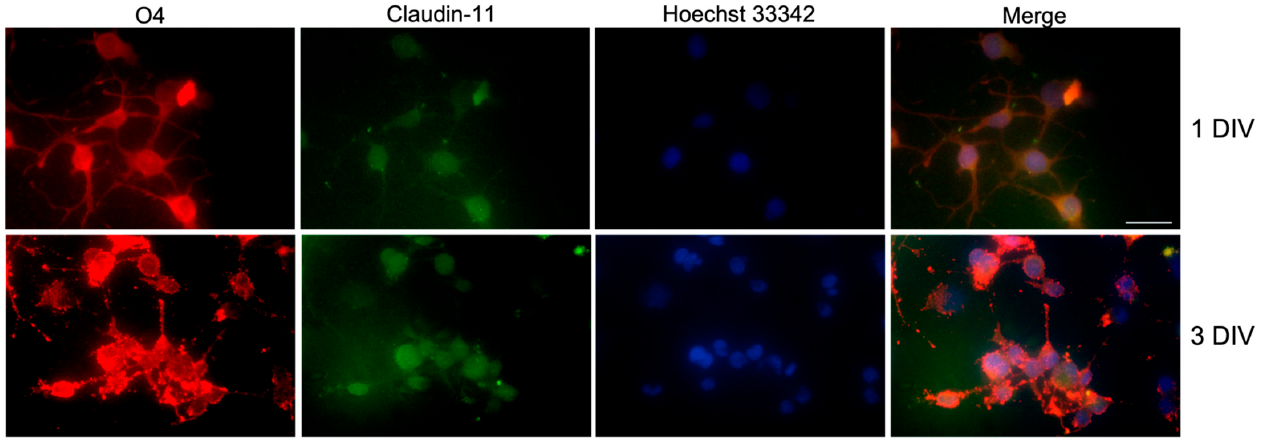
Figure 1. Immunocytochemistry showing the immunostaining for OL marker O4 (in red) and the myelin-associated protein Claudin-11 (in green) in Oli neu cells maintained for 1 and 3 DIV. Hoechst 33342 was used for nuclei staining. Scale bar: 20 μ m.